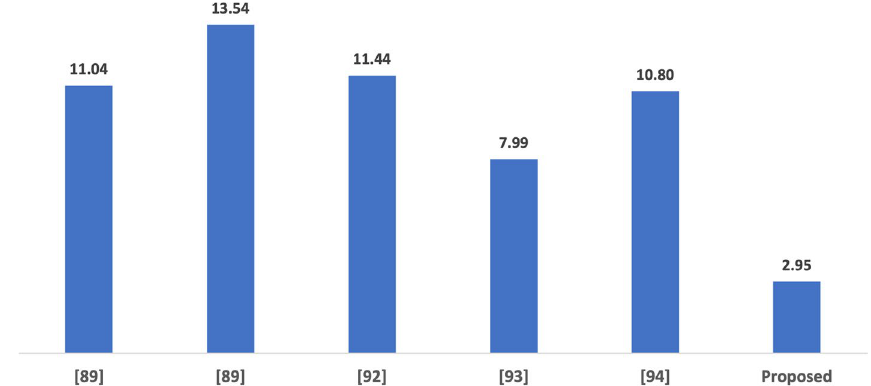
Fig. 15 Comparison with other